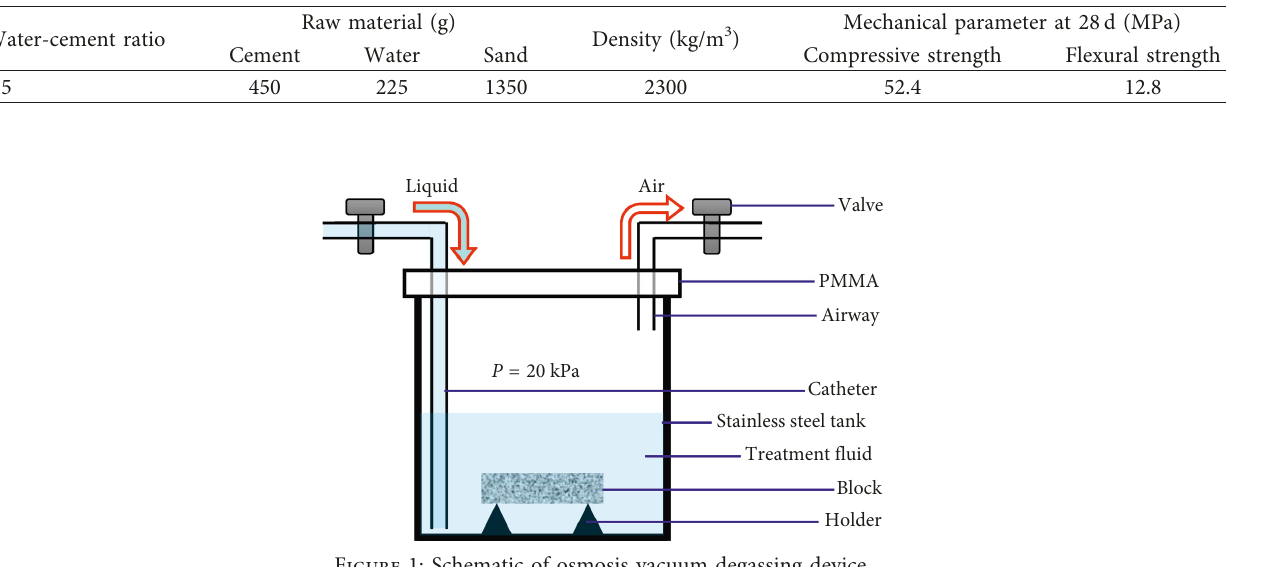
Table 2: Mix proportions and mechanical properties of the mortar.